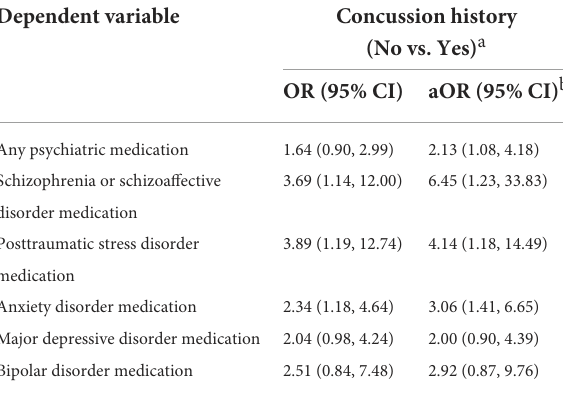
TABLE 2 Association between concussion history and medication non-adherence among homeless adults prescribed medication for a psychiatric disorder (0 = adherent, 1 = not